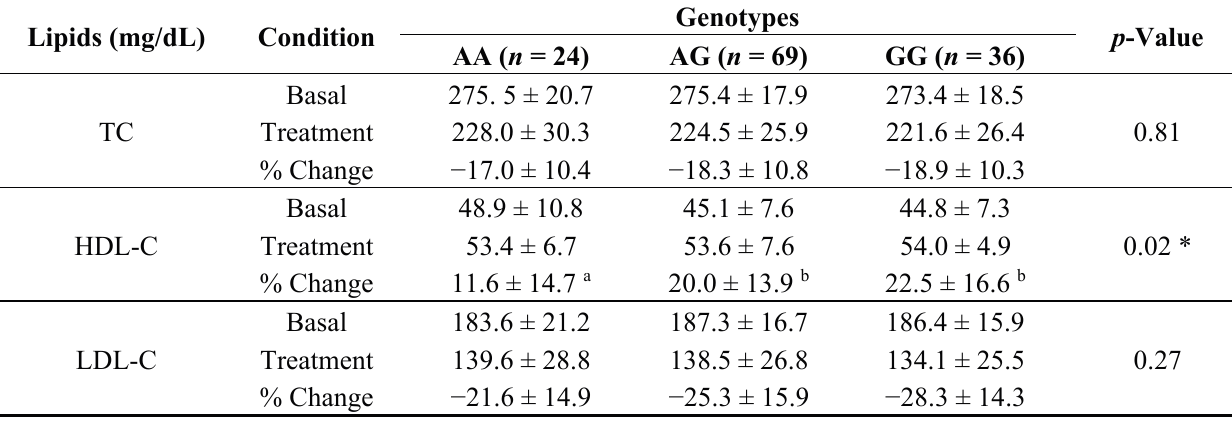
Table 4. Influence of the SLCO1B1 388A>G SNP on atorvastatin treatment (10 mg/day, 4 weeks). Lipids